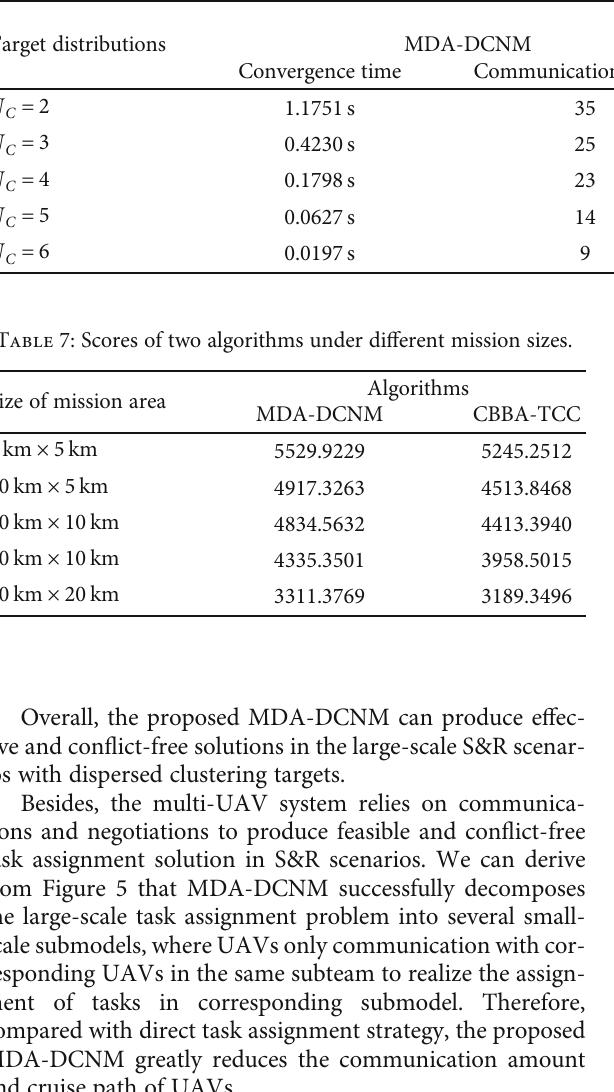
Table 6: Convergence performance of two algorithms under di ff erent target distributions.